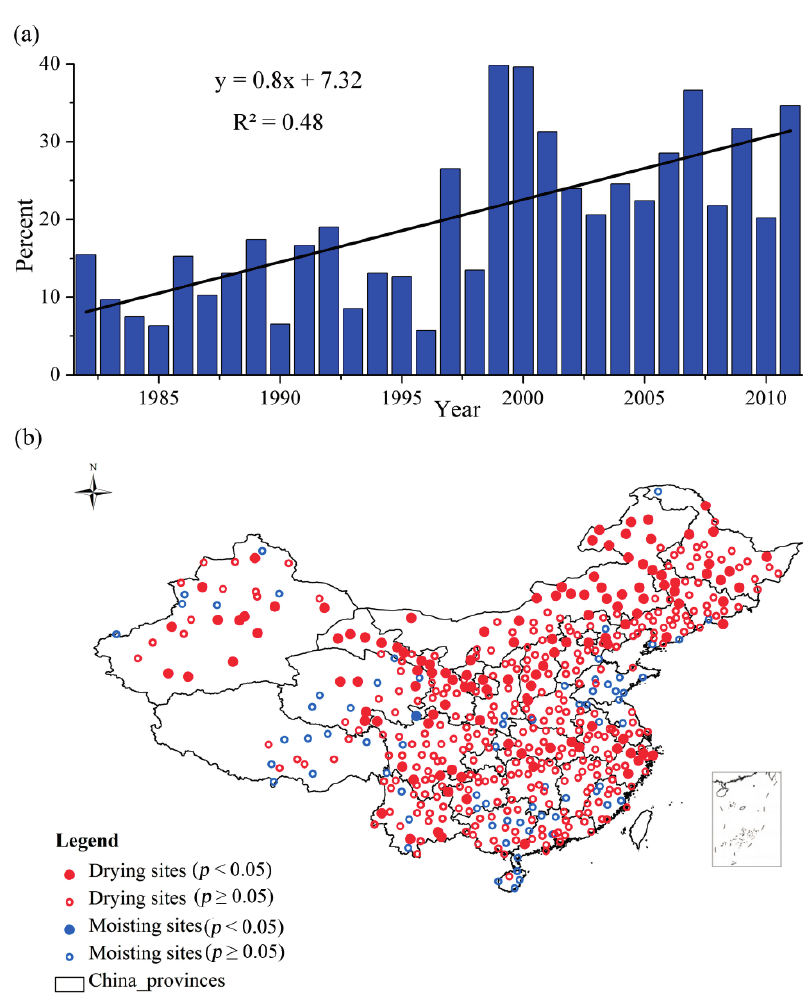
Figure 2. ( a ) The frequency of drought from 1982 to 2011 based on the SPEI-12; ( b ) The drying trend based on the SPEI-12 time series for each meteorological station over